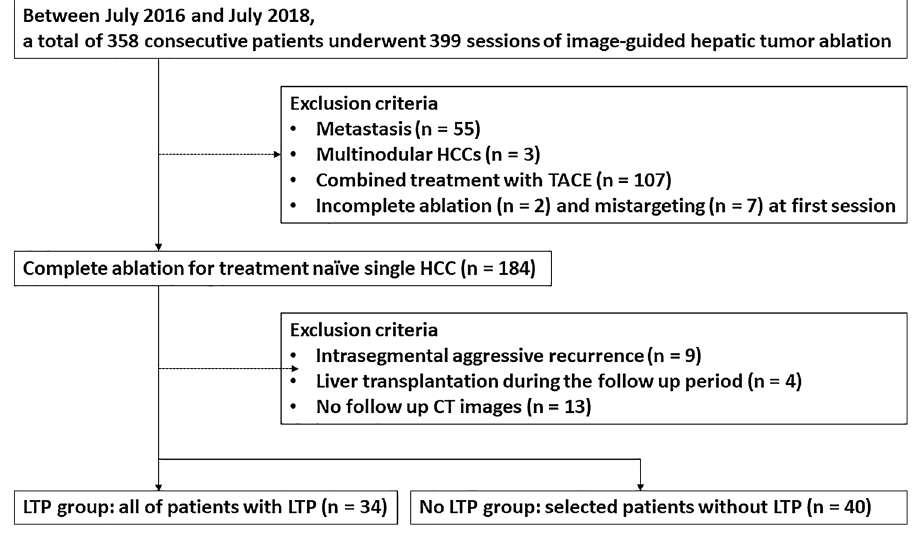
Figure 4. Flow diagram of study